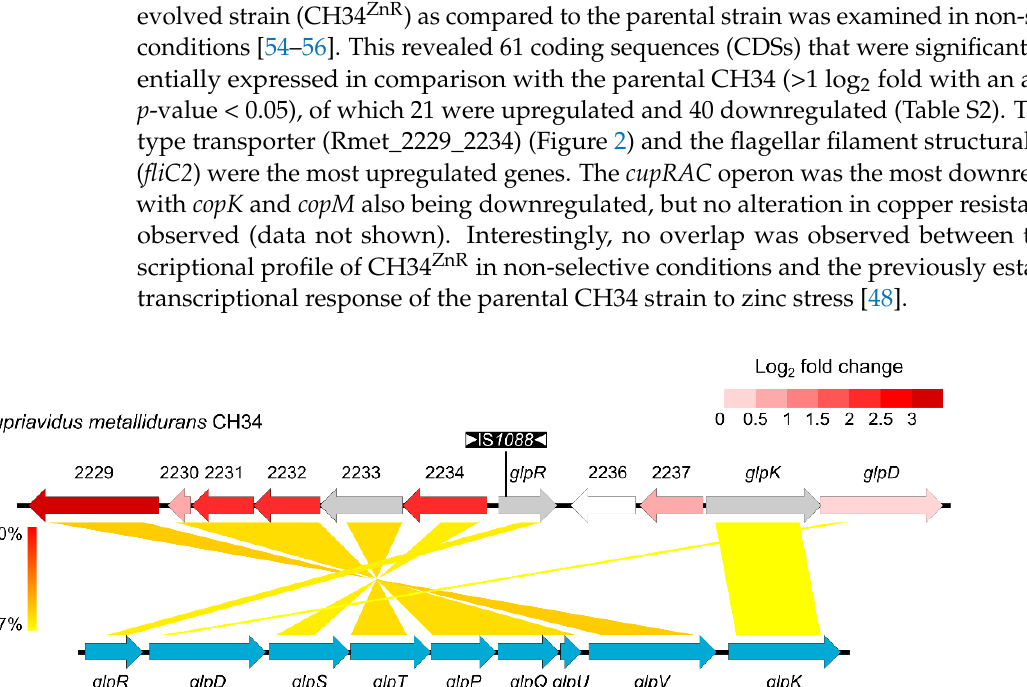
Figure 1. Cell survival upon exposure to 25 mM Zn 2+ of C. metallidurans CH34 (blue square) and 257 CH34 ZnR (red circles) without (full) or with (dashed) pre-induction with 300 µM Zn 2+ for 48 h. The 258 light grey dotted line represents the detection limit. The average values of three independent ex- 259 periments with standard deviations are shown. CFU: colony forming unit. 260